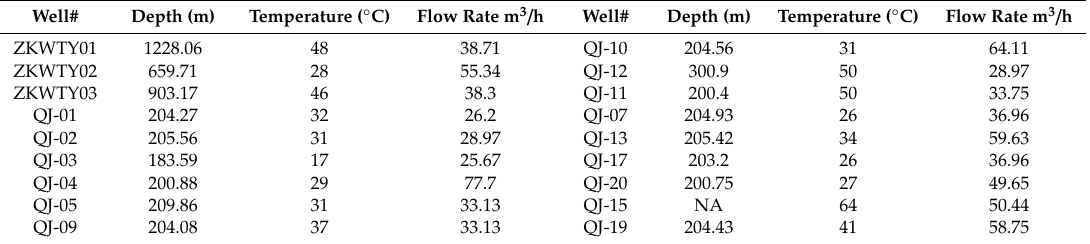
Table 1. Basic information for 18 wells in